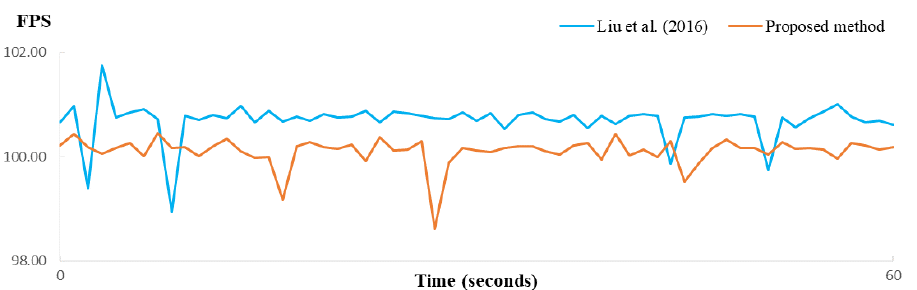
Figure 19. Average frames per second (FPS) for indoor scenes inside the Building Information Model (BIM) model when the outdoors is visible.